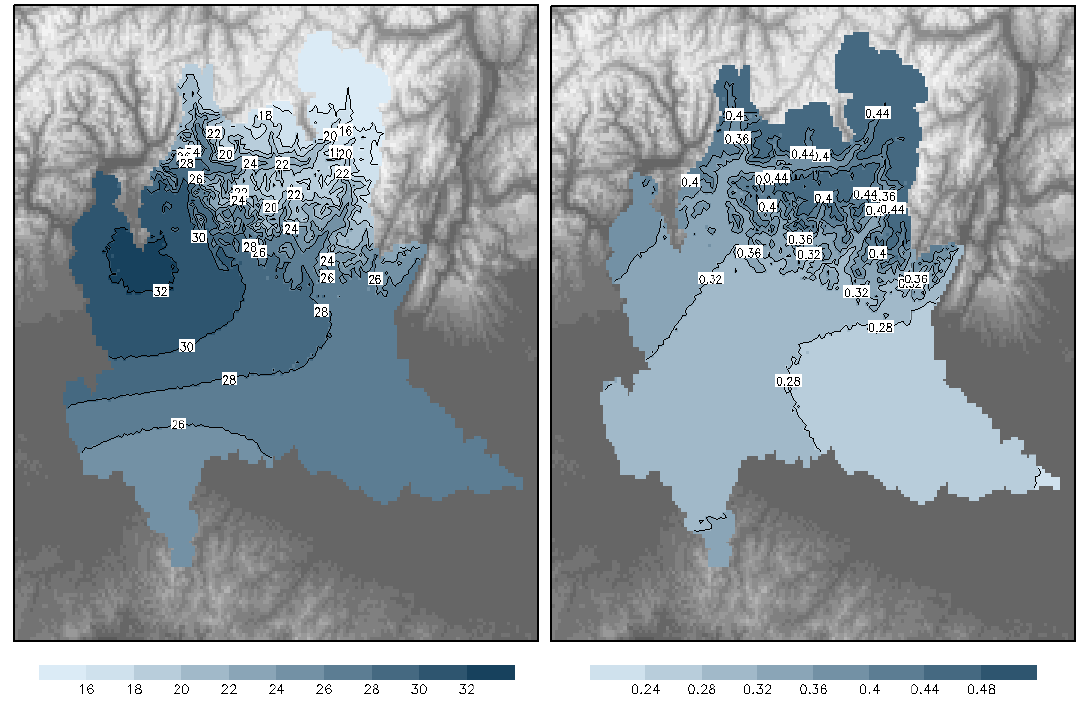
Fig. 4. Left: map of the estimated scale invariance coefficient a 1 (mm). Right: map of the estimated scaling exponent n (dimensionless).